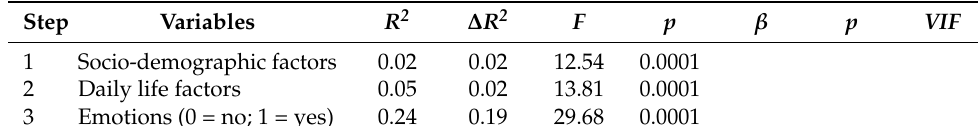
Table 6. Hierarchical regression analysis on GH12